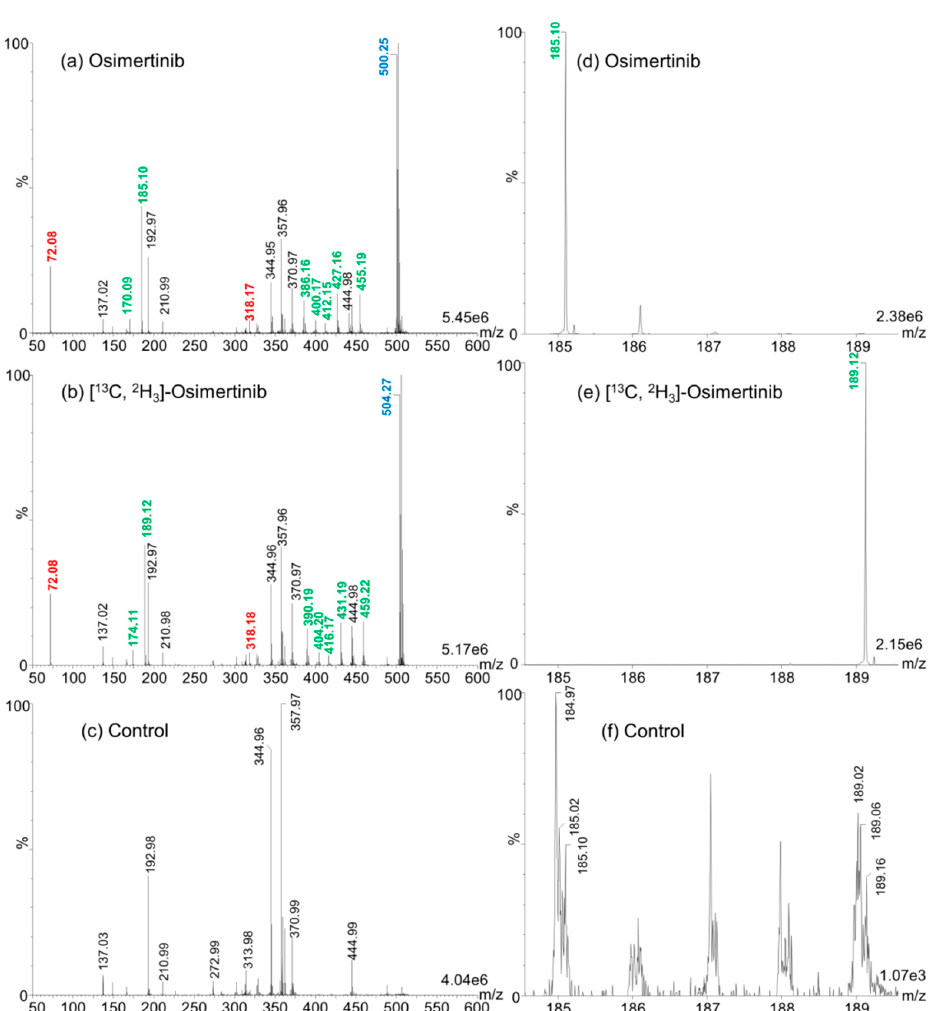
Figure 1. Di ff erential matrix-assisted laser desorption / ionization-ion mobility-tandem mass spectrometry (MALDI-IM-MS / MS) fragments between osimertinib and [ 13 C, 2 H 3 ]-osimertinib. ( a ) MALDI-IM-MS / MS spectrum of osimertinib. ( b ) MALDI-IM-MS / MS spectrum of [ 13 C, 2 H 3 ]-osimertinib. ( c ) MALDI-IM-MS / MS spectrum of 2,5-dihydroxybenzoic acid (2,5-DHB), used as control. The mass / charge ( m / z ) values in blue correspond to the native compounds. Red m / z values correspond to fragments that were found in common between osimertinib and [ 13 C, 2 H 3 ]-osimertinib. Green m / z values correspond to di ff erential fragments. Black m / z values represent peak fragments found in osimertinib, [ 13 C, 2 H 3 ]-osimertinib, and control solutions. ( d – f ) MALDI-IM-MS / MS spectra in the m / z range 184 to 190 of osimertinib, [ 13 C, 2 H 3 ]-osimertinib, and control, respectively. The maximum intensities are given in arbitrary units at the bottom right of each spectrum.